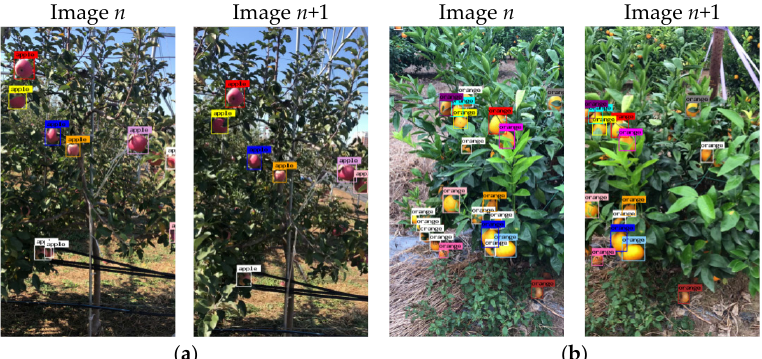
Figure 12. Examples of fruit matching in adjacent fruit images. ( a ) Result of fruit matching in adja- cent apple images. ( b ) Result of fruit matching in adjacent orange images.